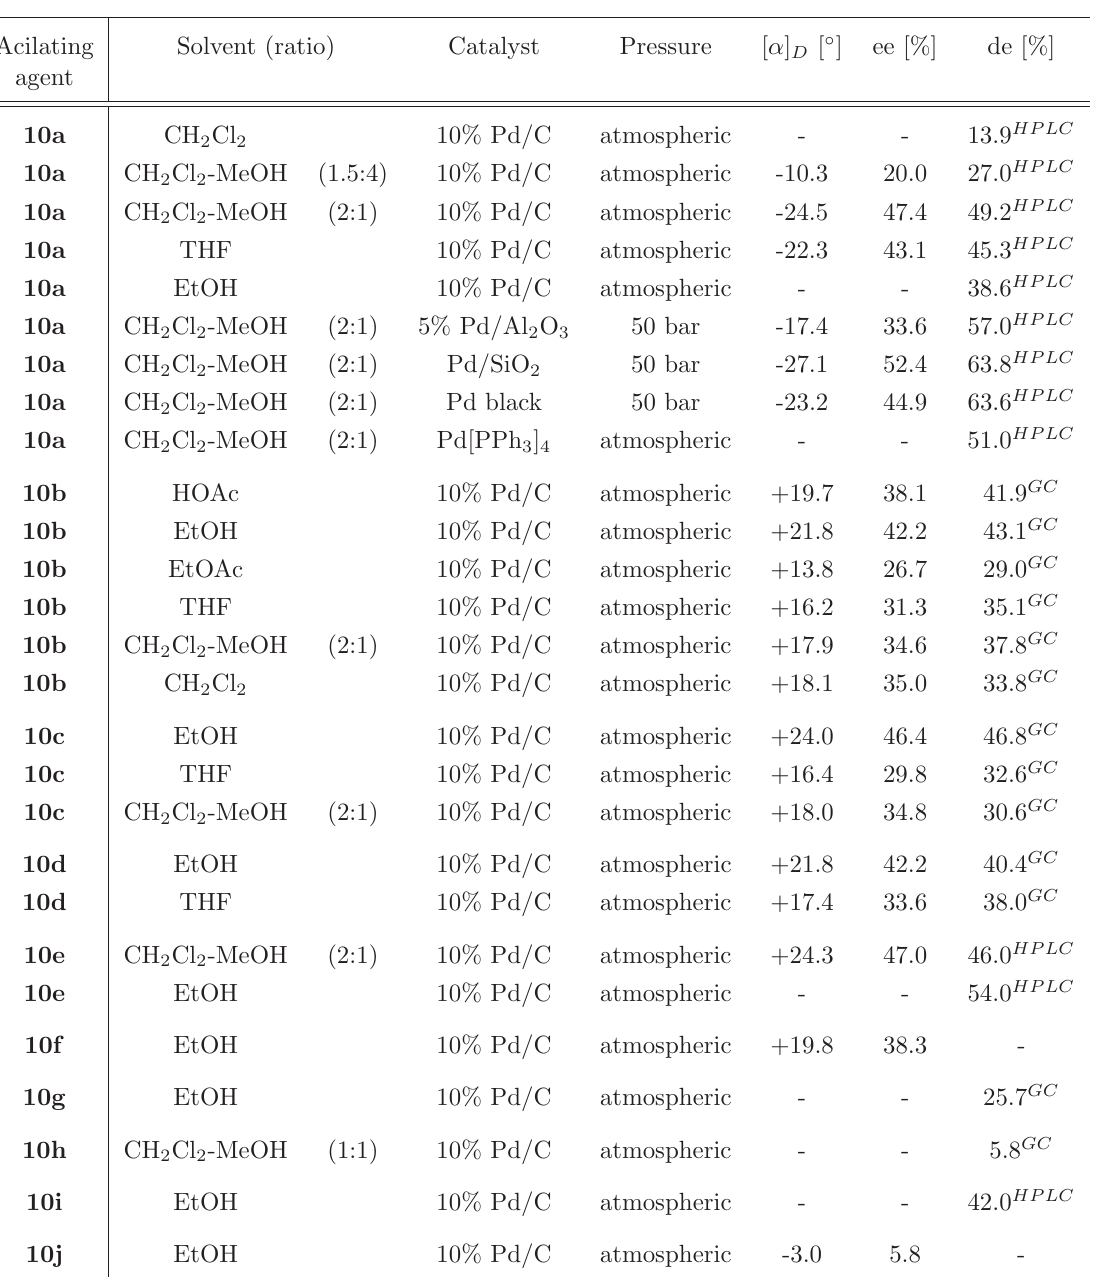
Table 1 Effect of reaction conditions of hydrogenation on